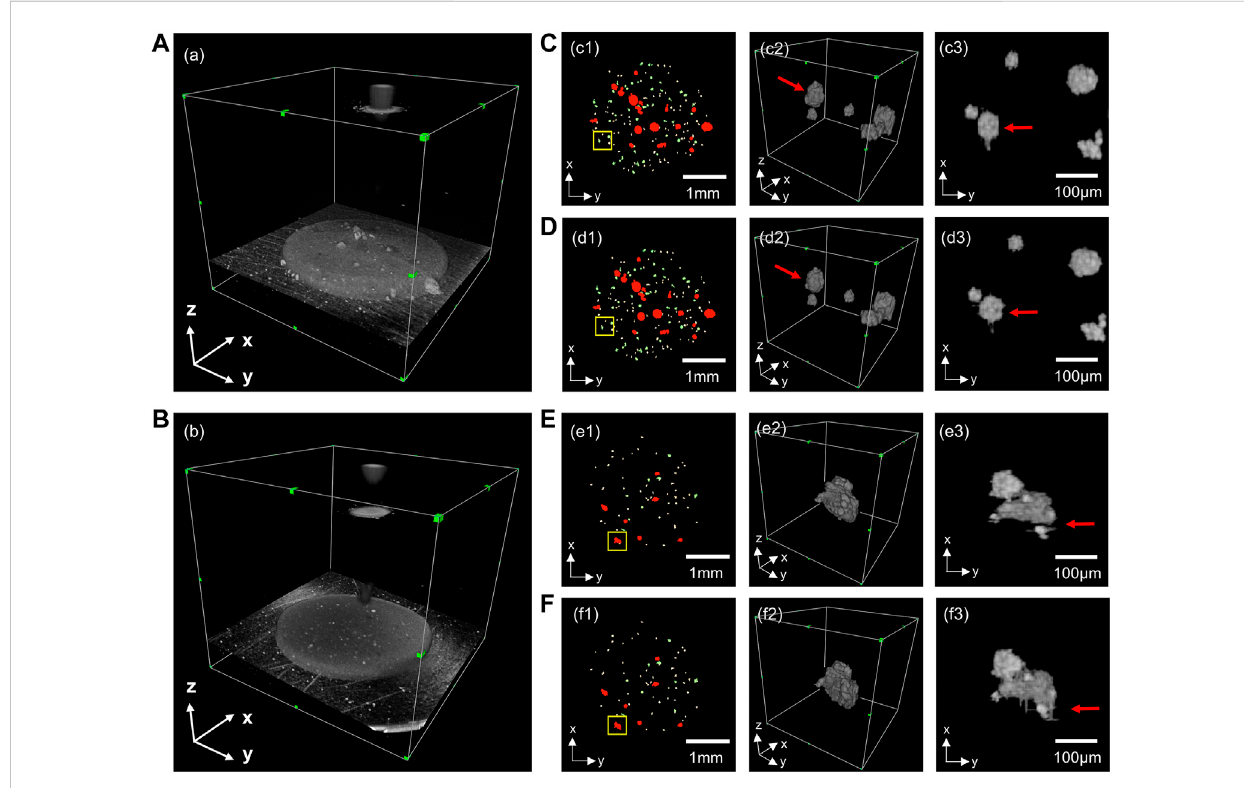
FIGURE 4 Comparison of the 3D segmentation results of unidirectional prediction and orthogonal continuous input prediction. (A,B) are two sets of 3D OCT examples; (C,E) are3Dsegmentationswithunidirectionalprediction. (D,F) are3Dsegmentationswithorthogonalcontinuousinputprediction.(c1 – f1)are topviewsof3Dreconstructionsoforganoidssegmentation;(c2 – f2)areenlarged 3Dreconstructions oftheyellowboxes in(c1 – f1);(c3 – f3)aretop views corresponding of (c2 –